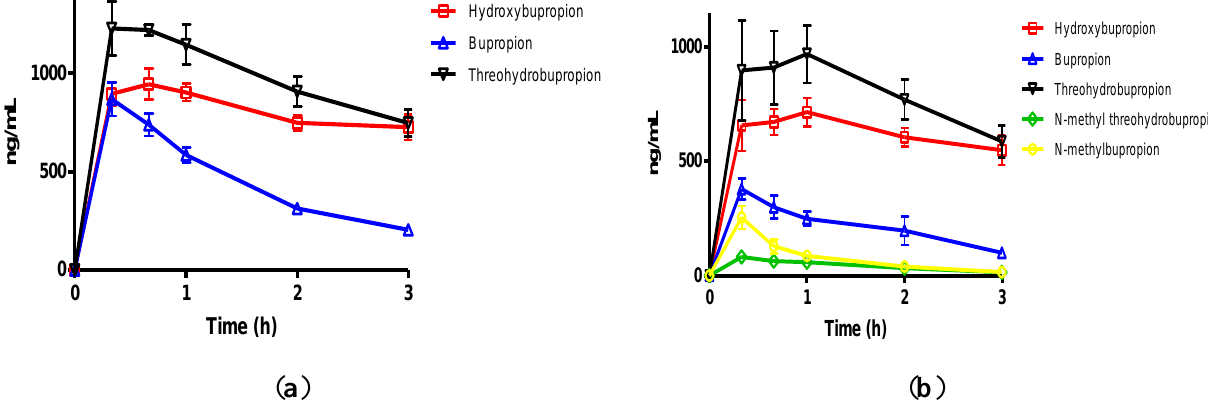
Figure 3. ( a ) The mean plasma levels of bupropion and metabolites after dosing 40 mg/Kg bupropion to guinea pigs by IP injection ( n = 5); ( b ) The mean plasma concentrations of N -methylbupropion and metabolites after dosing 42 mg/Kg N-methylbupropion to guinea pigs by IP injection ( n = 5).